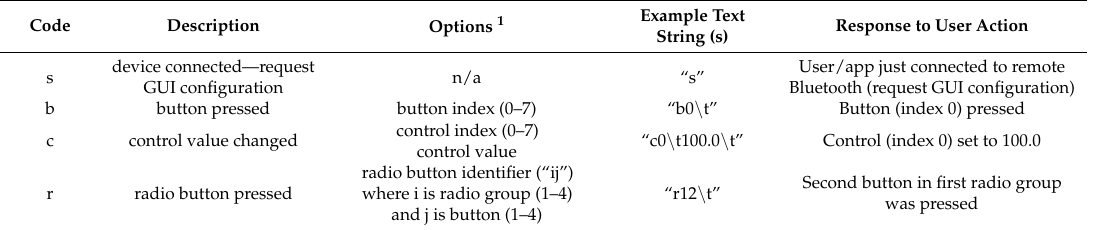
Table 3. Coded information from ABE-VIEW to remote device indicating user interactions with